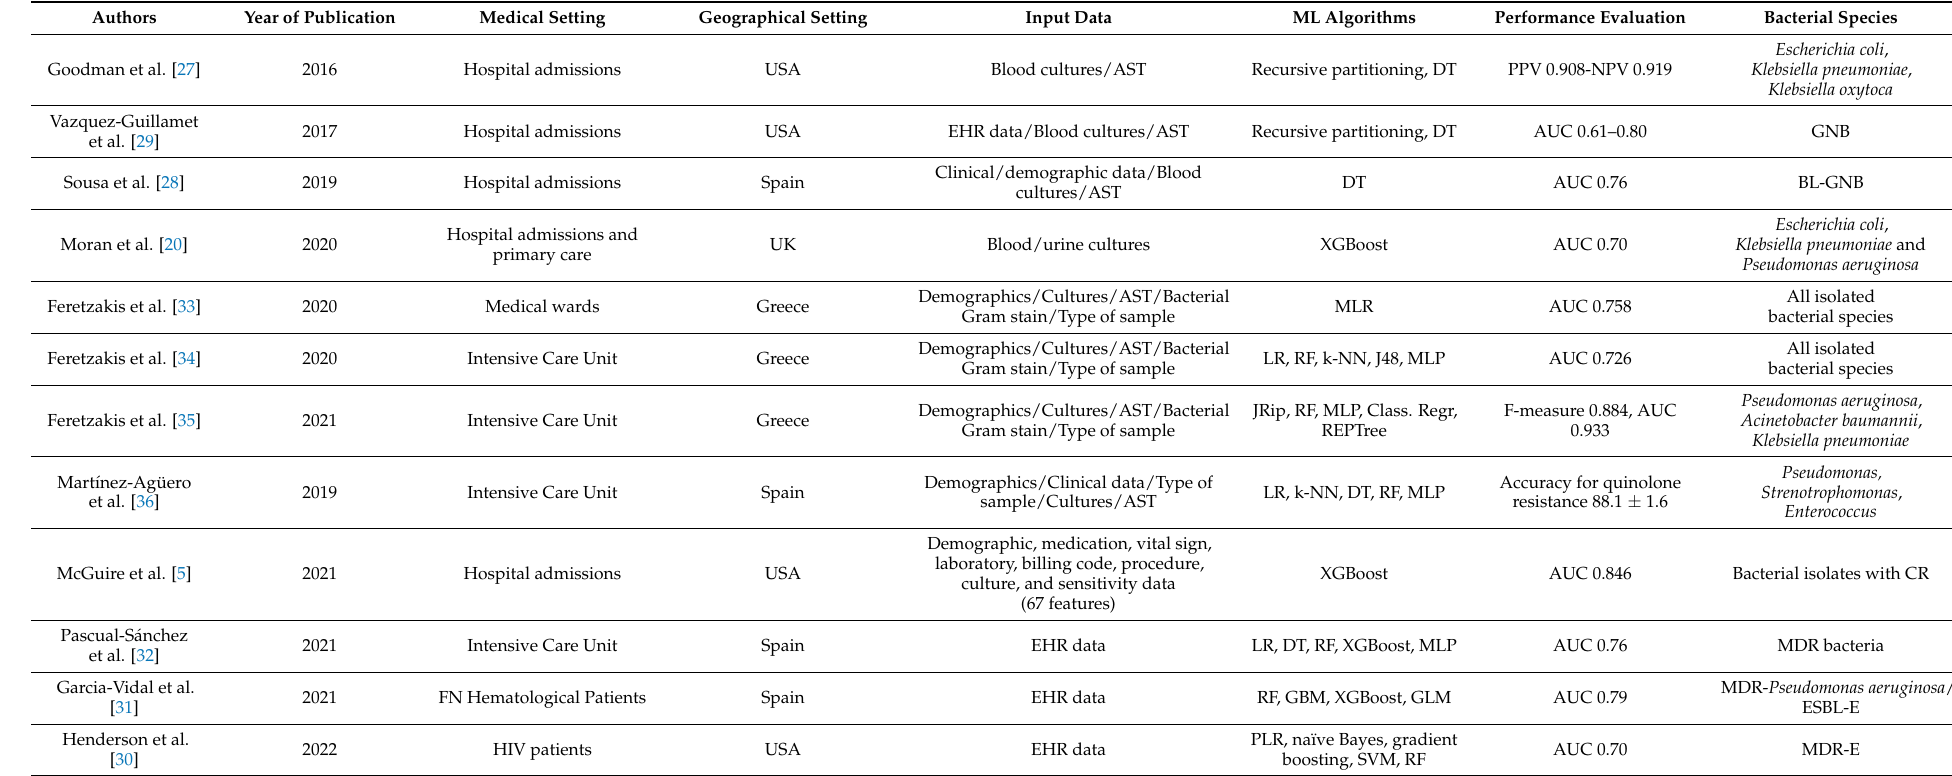
Table 1. Performance of machine learning across different studies in predicting antibiotic susceptibility